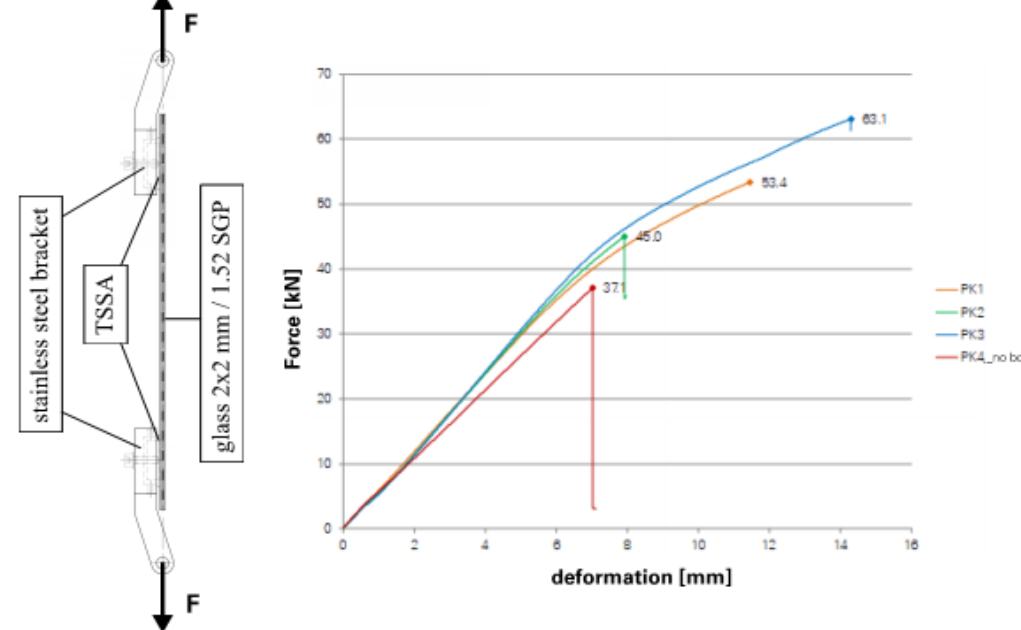
Fig. 14 Experiment set-up and force-deformation diagram of the accelerated